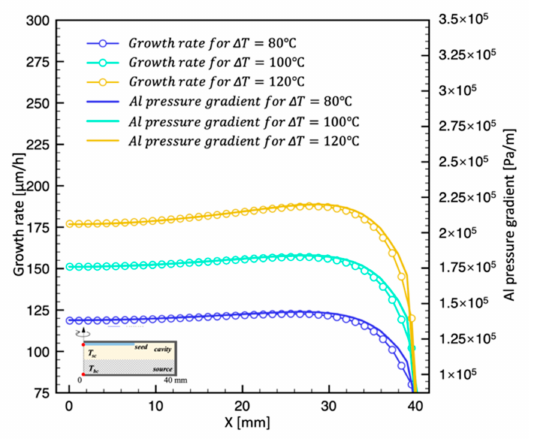
Figure 10. Profiles of growth rate and Al vapor partial pressure gradient along the seed surface at ∆ T = 80 ◦ C, 100 ◦ C, and 120 ◦